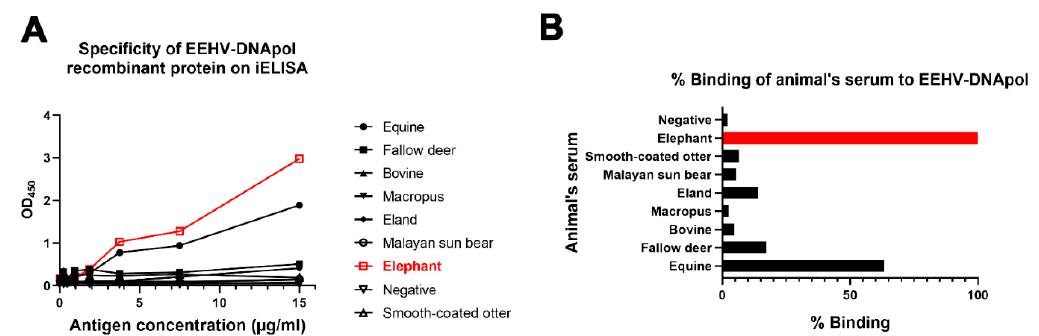
Figure 1. Cross-reactivity of EEHV-DNApol ELISA results with animal sera. Elephant serum (red) Figure 1 . Cross - reactivity of EEHV - DNApol ELISA results with animal sera . Elephant serum (red) indicated 100% specificity with the EEHV-DNApol recombinant protein, followed by equine and indicated 100 % specificity with the EEHV - DNApol recombinant protein, followed by equine and fallow deer at 63.5% and 17.2%, respectively ( A , B ). Other sera indicated low %binding (less than fallow deer at 63 . 5 % and 17 . 2 % , respectively ( A , B ). Other sera indicated low % binding ( less than 20 %) to 20%) to EEHV-DNApol EEHV - DNApol antigens .